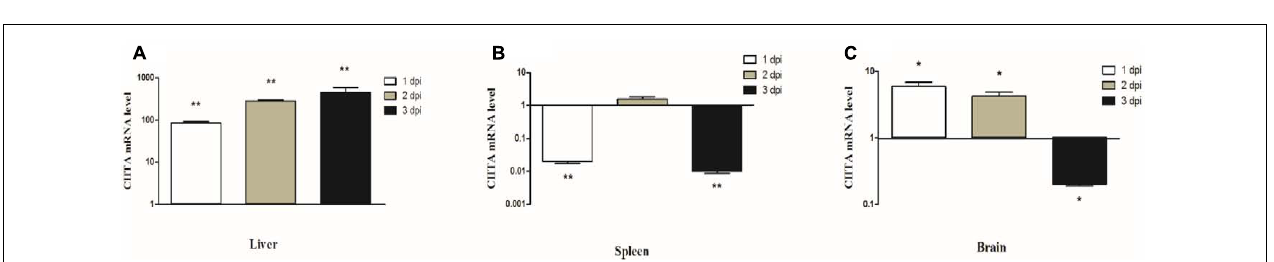
FIGURE 6 | Relative mRNA expression levels of duCIITA in liver, spleen, and brain of the APEC-infected ducks. (A) Liver, (B) Spleen, (C) Brain. The fold change was calculated by the experimental ducks vs. control ducks at the same time point, using the 2 − (cid:49)(cid:49) C T method. All data were expressed as means ± SD ( n = 3), and Student’s t -test was performed to evaluate the differences. ∗ Significant difference ( P < 0.05); ∗∗ highly significant difference ( P < 0.01); dpi, days post-infection.